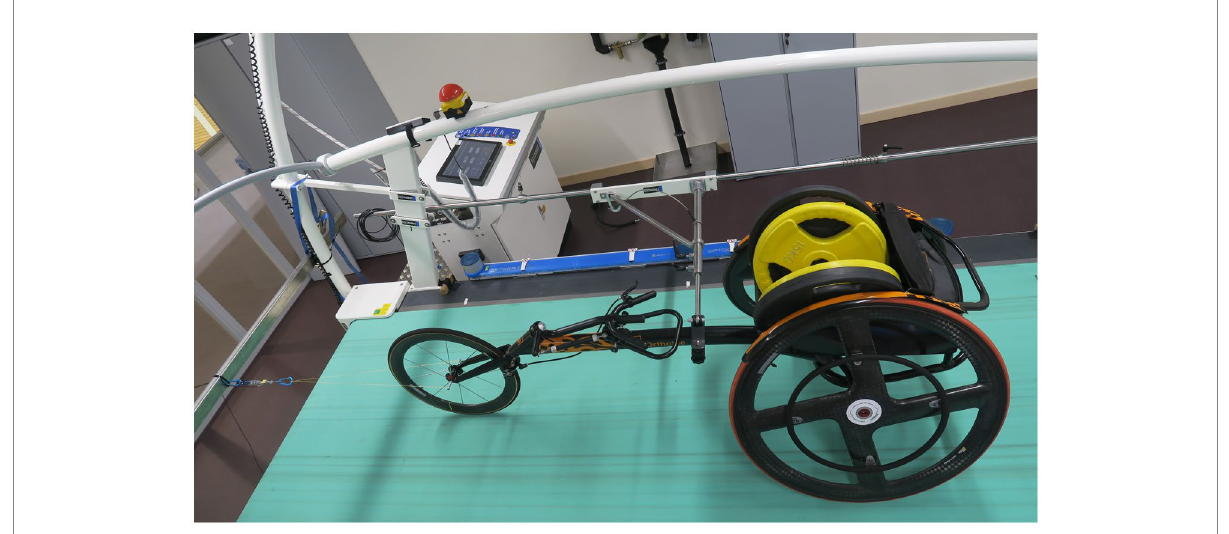
FIGURE 1 Wheelchair on the treadmill, loaded with a weight of 80 kg for the drag test, attached to the fixation system alongside of the treadmill and to the force sensor in front.